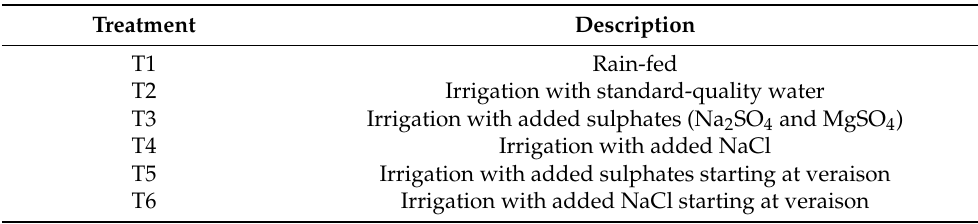
Table 2. Description of the experimental treatments carried out in a vineyard cv. Monastrell, located in south-eastern Spain, in the 2018, 2019, and 2020 seasons. Treatment Description T1 Rain-fed Irrigation with standard-quality